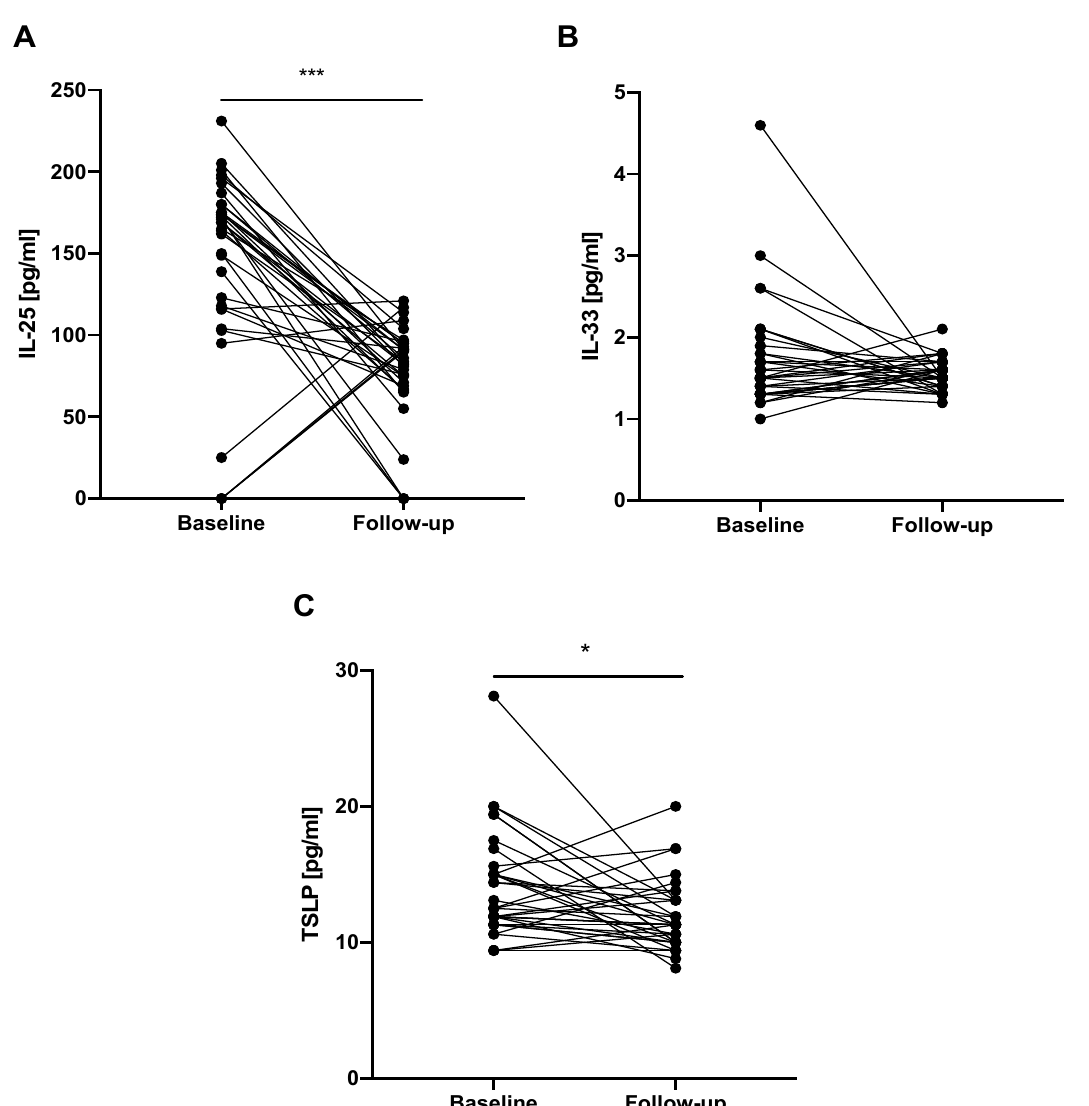
Figure 5. Changes in the epithelial alarmin levels in the EBC of patients with IPF before and after 12 months of antifibrotic therapy. Notes: Panels showing: ( A ) change in IL-25 EBC level; ( B ) change in IL-33 EBC level; ( C ) change in TSLP EBC level; * p < 0.05, *** p < 0.001. EBC—exhaled breath condensate, IPF—idiopathic pulmonary fibrosis, IL-25—interleukin 25, IL-33—interleukin 33, TSLP—thymic stromal lymphopoietin.